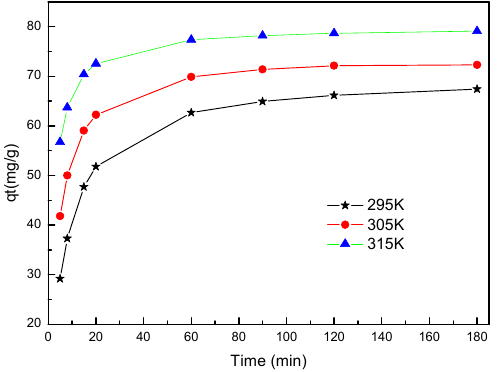
Figure 7. Effect of contact time and temperature on the adsorption rates of Pd(II) onto BISIN.